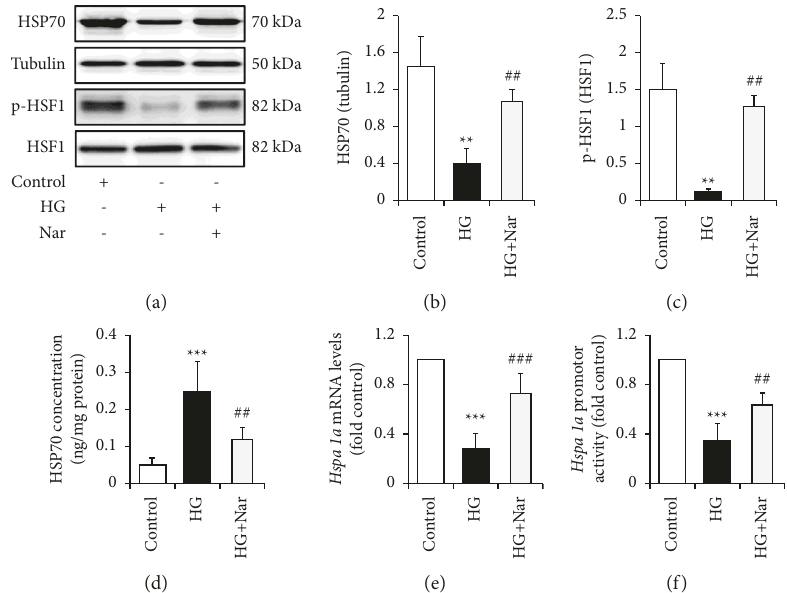
Figure 5: Effect of Nar on HG-reduced HSP70 levels. HUVECs were exposed to NG (5.5mM glucose) or HG (30mM glucose) media with or without the 50mM of Nar for 36h. (a). Effect of Nar on iHSP70 levels and HSF1 phosphorylation. (b) Quantification of iHSP70 levels in (a). (c) Quantification of HSF1 phosphorylation in (a). (d) Effect of Nar on HSP70 concentration in the culture media. (e) Effect Nar on Hspa1a mRNA levels. (f) Effect of Nar on Hspa1a promotor activity. Data are expressed as means ± SD ( n � 3). ∗∗ P < 0 . 01 and ∗∗∗ P < 0 . 001 versus control (NG) group. ## P < 0 . 01 and ### P < 0 . 001 versus high-glucose (HG)